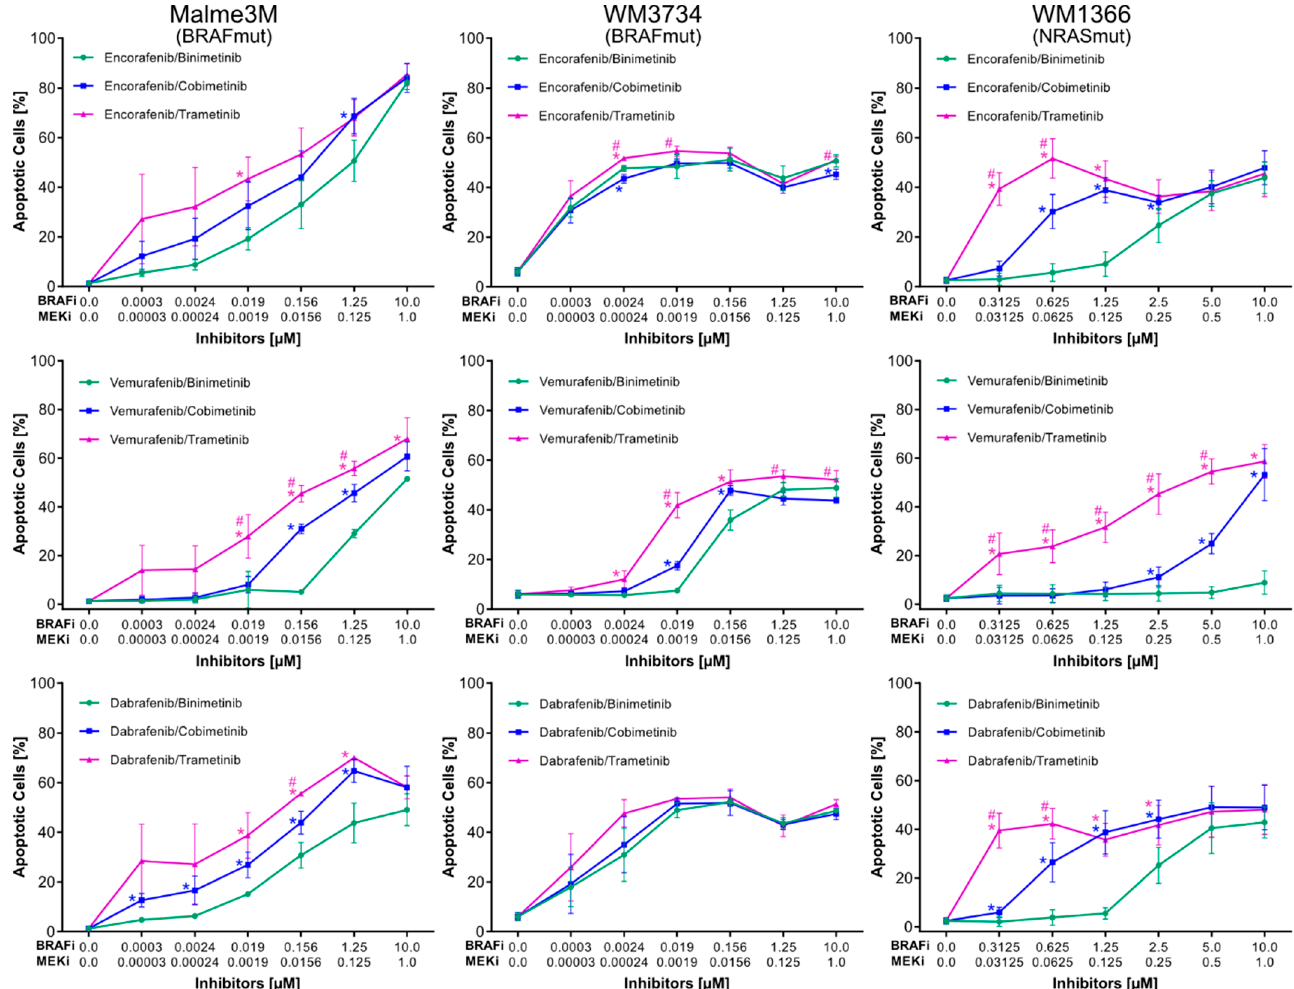
Figure 2. Sub-G1 (apoptosis) of two BRAF mut cell lines (Malme3M and WM3734) and one NRAS mut cell line (WM1366) after treatment for 72 h using different BRAFi/MEKi combinations with increasing concentrations of inhibitors (BRAF mut 1:8 serial dilutions, NRAS mut 1:2 serial dilutions). Identical data, as in Figure 1, are arranged differently for improved comparability; n ≥ 3, error bars indicate standard deviation, * indicates significantly different values relative to binimetinib, # labels data points that are significantly different relative to cobimetinib. Significance defined as p < 0.05 based on two-tailed non-paired t -test. Table S2 shows a complete list of p -values for all data points.